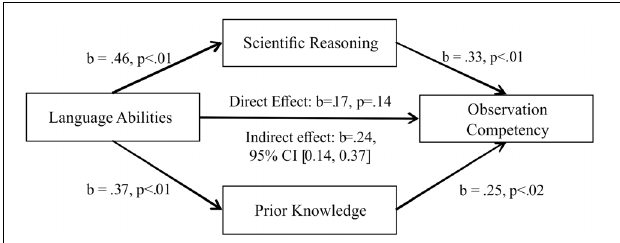
FIGURE 2 | Mediation analysis of the indirect effect of language on observation competency through scientific reasoning and prior knowledge.